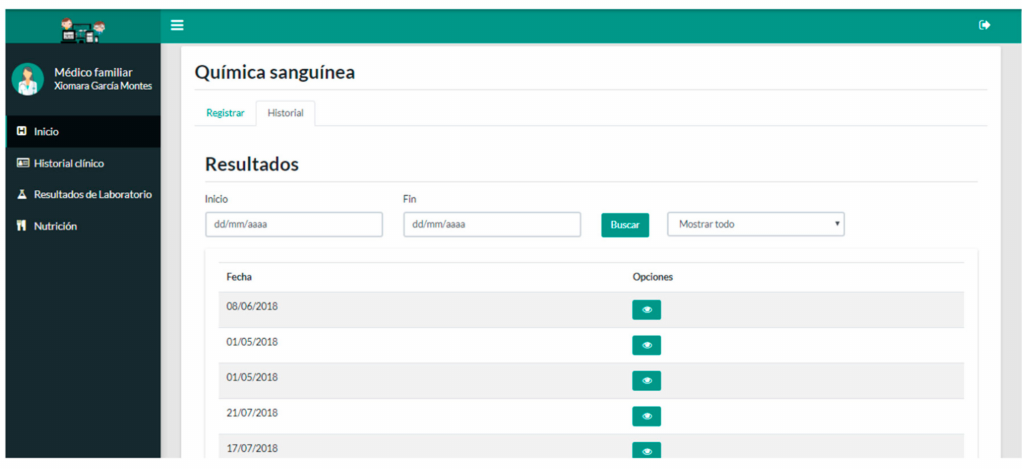
Figure 24. Physician application interface: Detail of the laboratory results of a blood chemistry